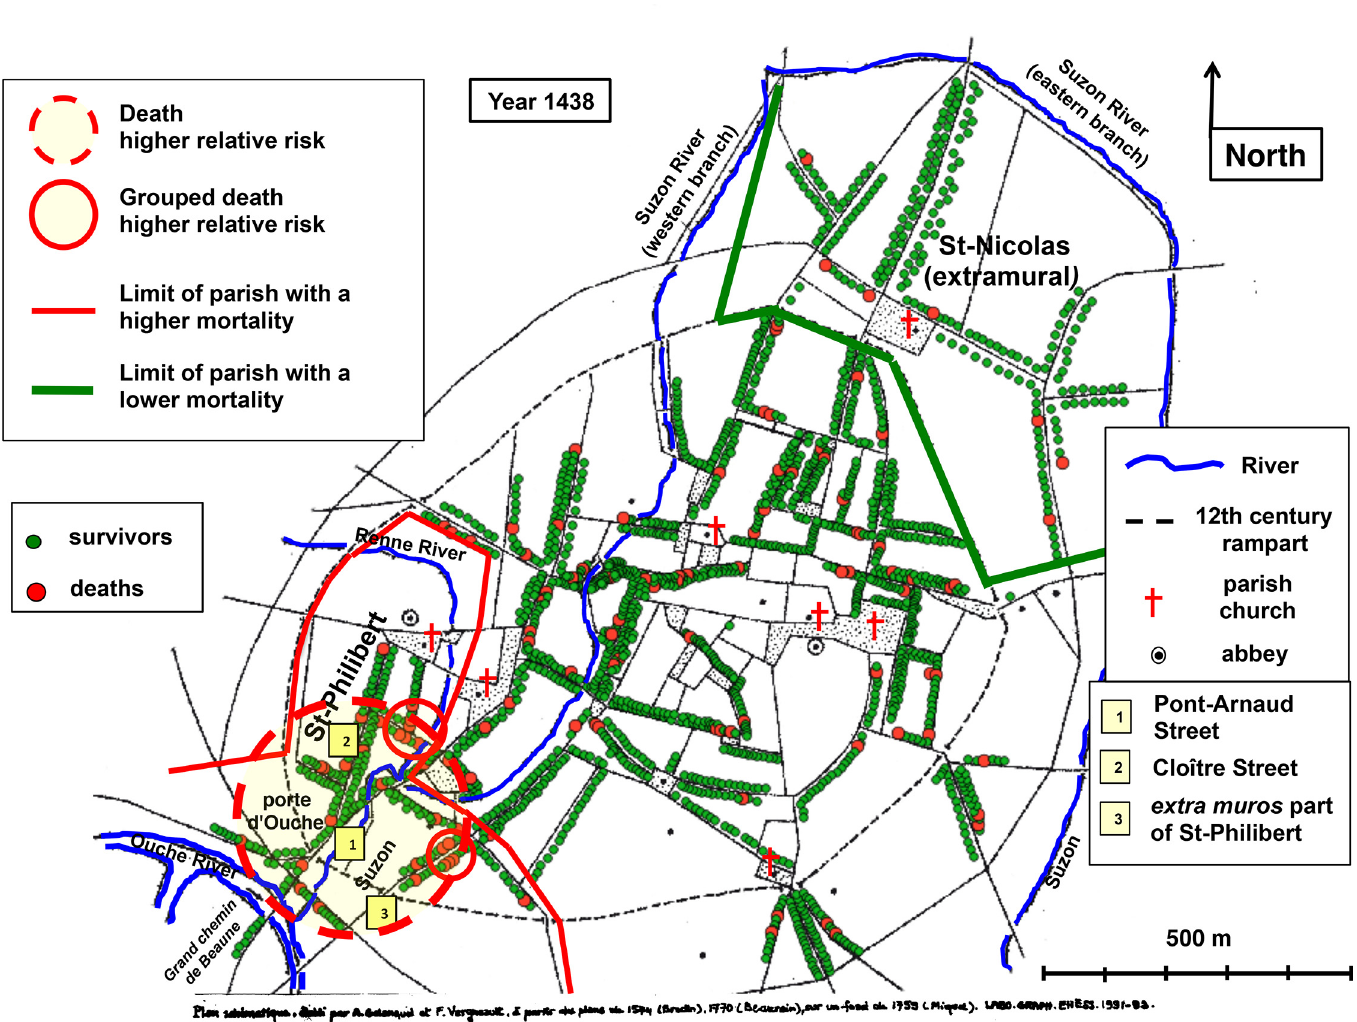
Fig 5. Cartography of death in 1438. Georeferenced map of medieval Dijon. Rivers as blue lines. Parish churches, abbeys and a number of prominent places are indicated. The 12th century rampart is shown by dotted lines. Each point corresponds to a surviving head of household (green points) or to a registered death (larger red points). Yellow area circled in dotted red line: spatial cluster with a higher relative risk of death. Yellow areas circled in solid red line: clusters with a higher relative risk of grouped deaths. The limits of the parish with a higher mortality ( Saint-Philibert ) are in red. The limits of the parish with a lower mortality (extramural part of Saint-Nicolas ) are in green. Historical evidence of the location of the statistically significant clusters is presented in S11 Text .